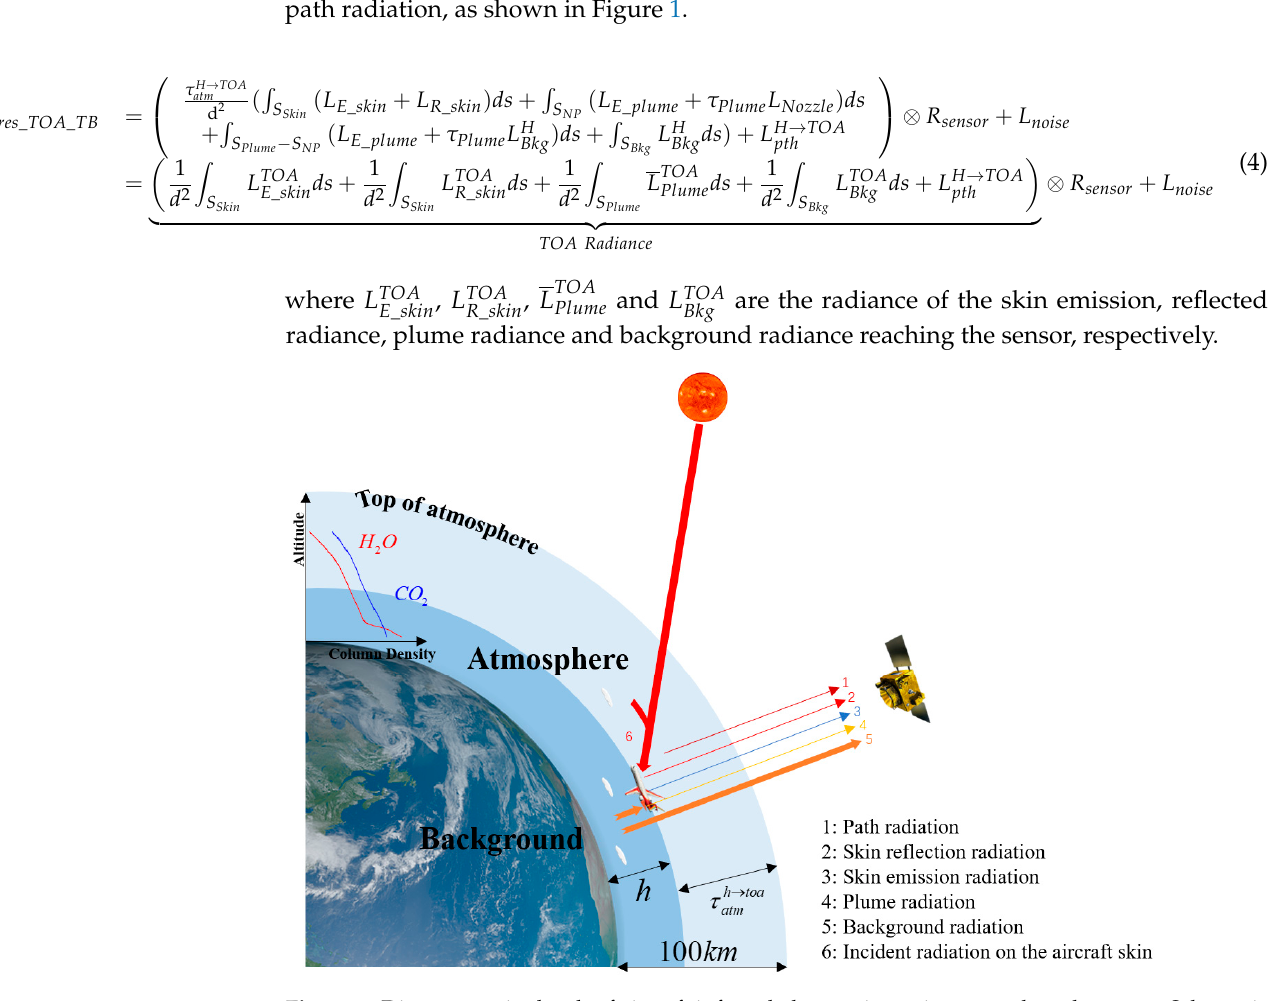
Figure 1. Diagrammatic sketch of aircraft infrared observation using space-based sensors. Schematic CO 2 and H 2 O column density diagrams with altitude are in the upper left corner.